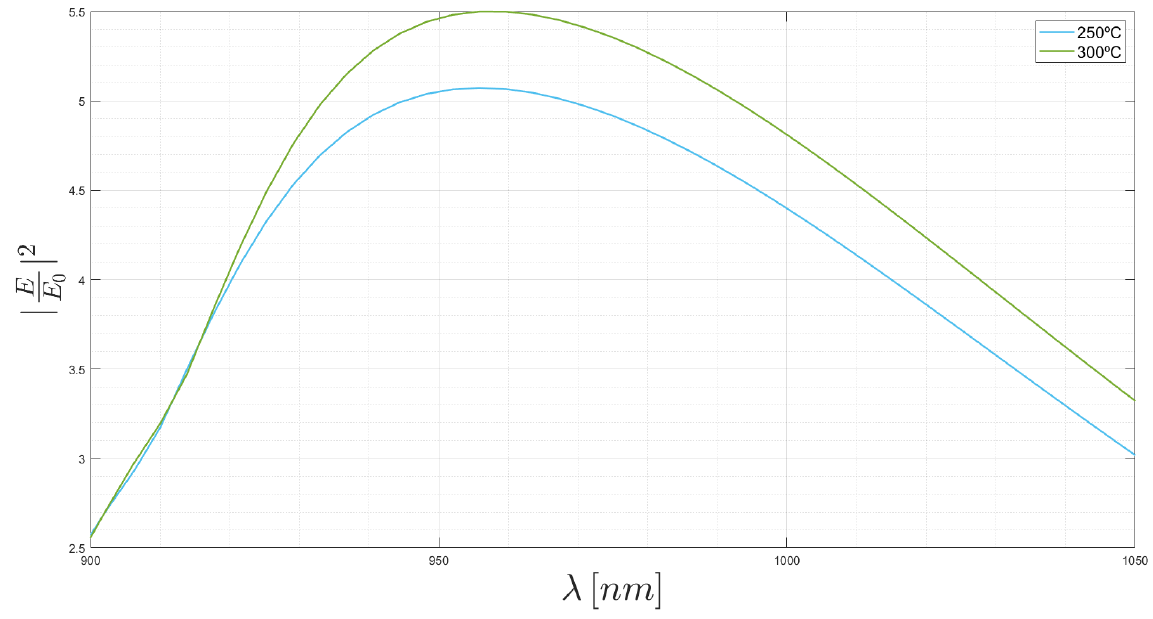
Figure 14. Gold nanostructure response for different temperatures above the critical one.